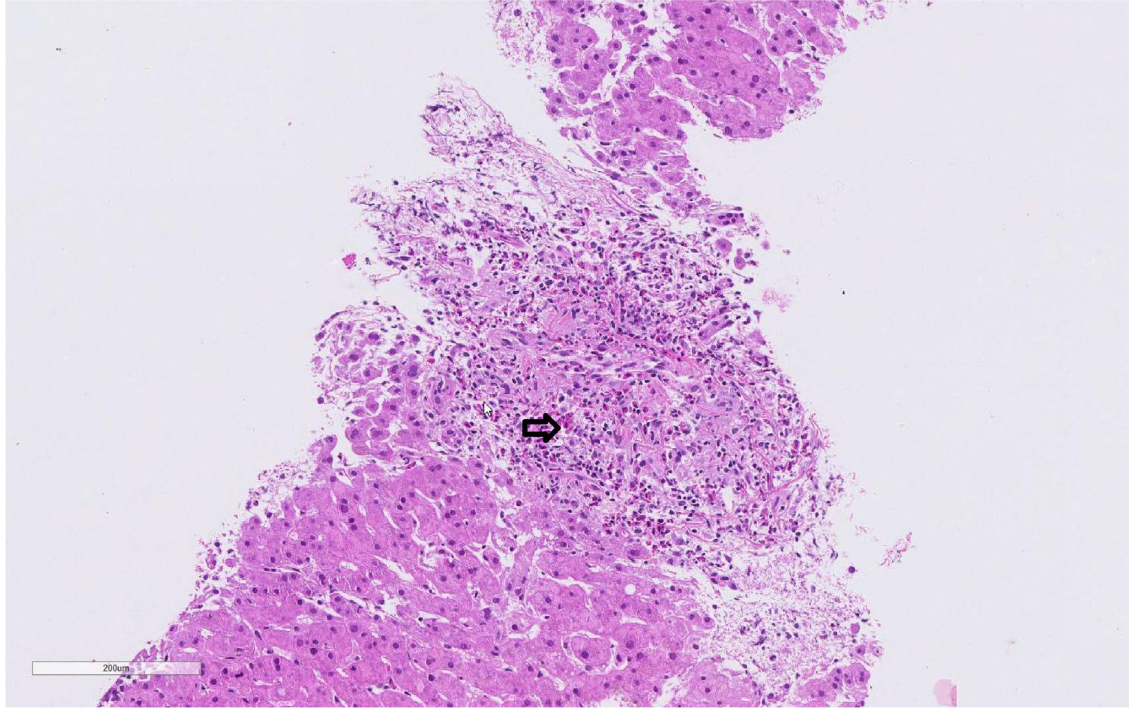
Figure 4. Case 3 liver biopsy: eosinophilic portal field infiltrate (arrow, hematoxylin-eosin,